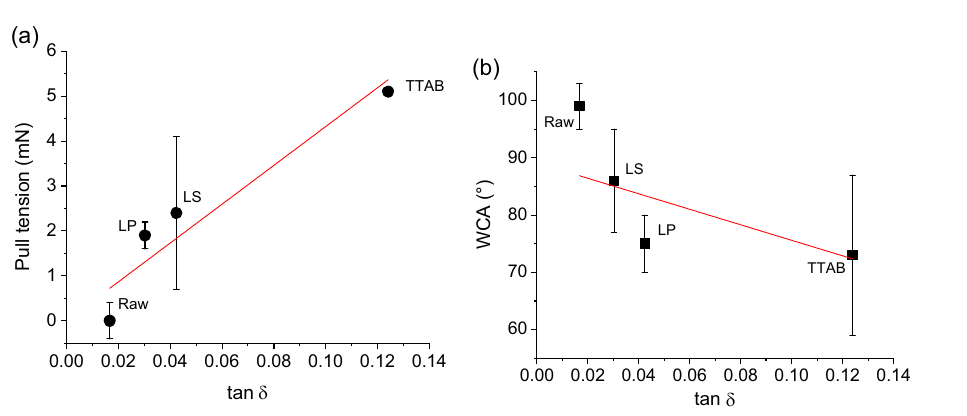
Figure 8. Correlation analysis between fiber-on-fiber frictional energy loss and fiber surface